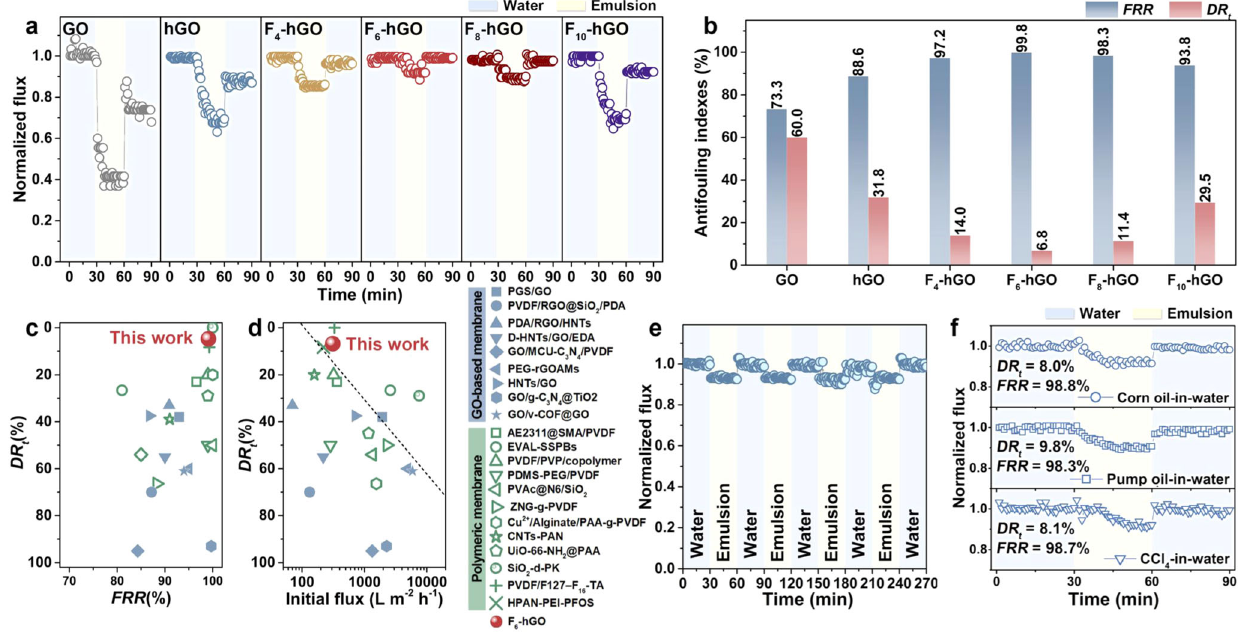
Fig. 4 | Antifouling performances of the membranes. a Time-dependent nor- malized fl uxesoftheGO,hGO,andF-hGOmembranesduringantifoulingtests.The used oily wastewater is a hexadecane-in-water emulsion. b Antifouling indexes of theGO,hGO,andF-hGOmembranes. c Comparisonofantifoulingperformancesof theF 6 -hGOmembraneandthereportedmembranesforoil-waterseparation. d DR t